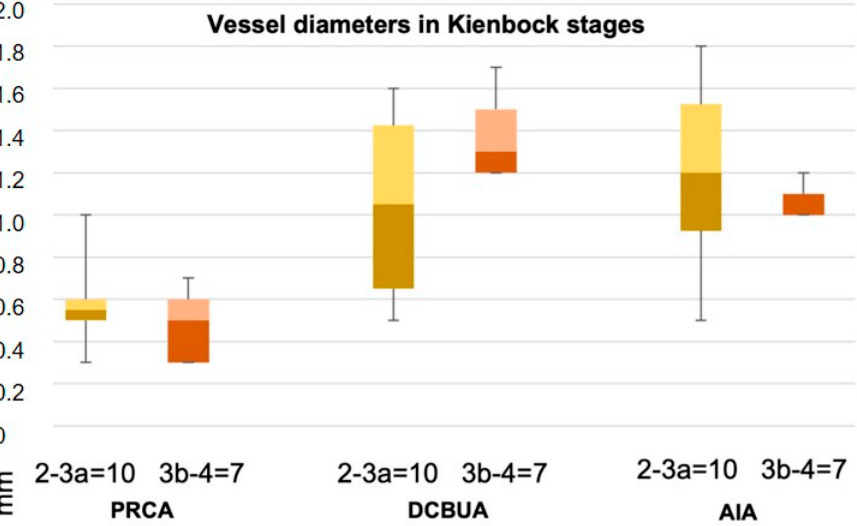
Figure 6. Mean vessel diameters of the palmar radiocarpal arch (PRCA), the dorsal carpal branch of the ulnar artery (DCBUA), and the anterior interosseous artery (AIA) in Kienbock’s disease stages 2–3a versus 3b did not differ significantly. Box plots with min/max values, median 25th and 75th percentile.